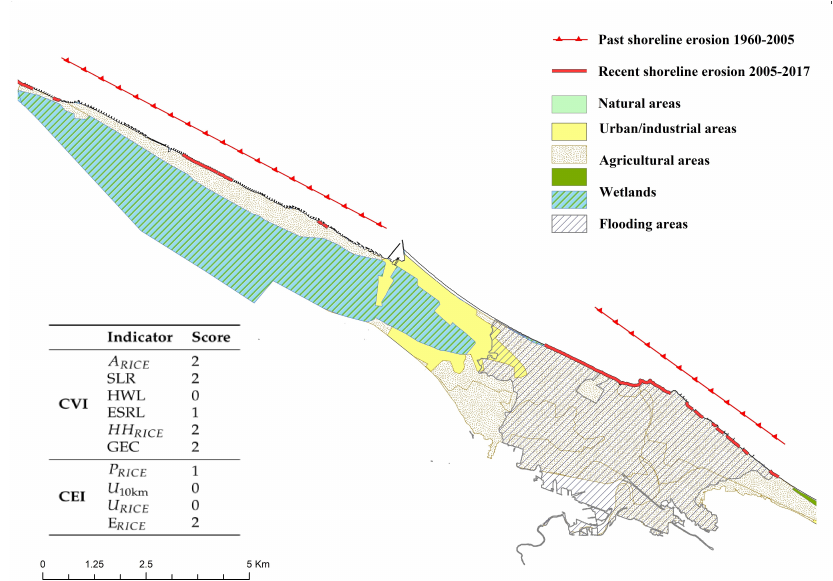
Figure 4. Land use, coastal erosion, and hydraulic hazard in the test site. The table reports CVI and CEI scores estimated under RCP 4.5 and 8.5